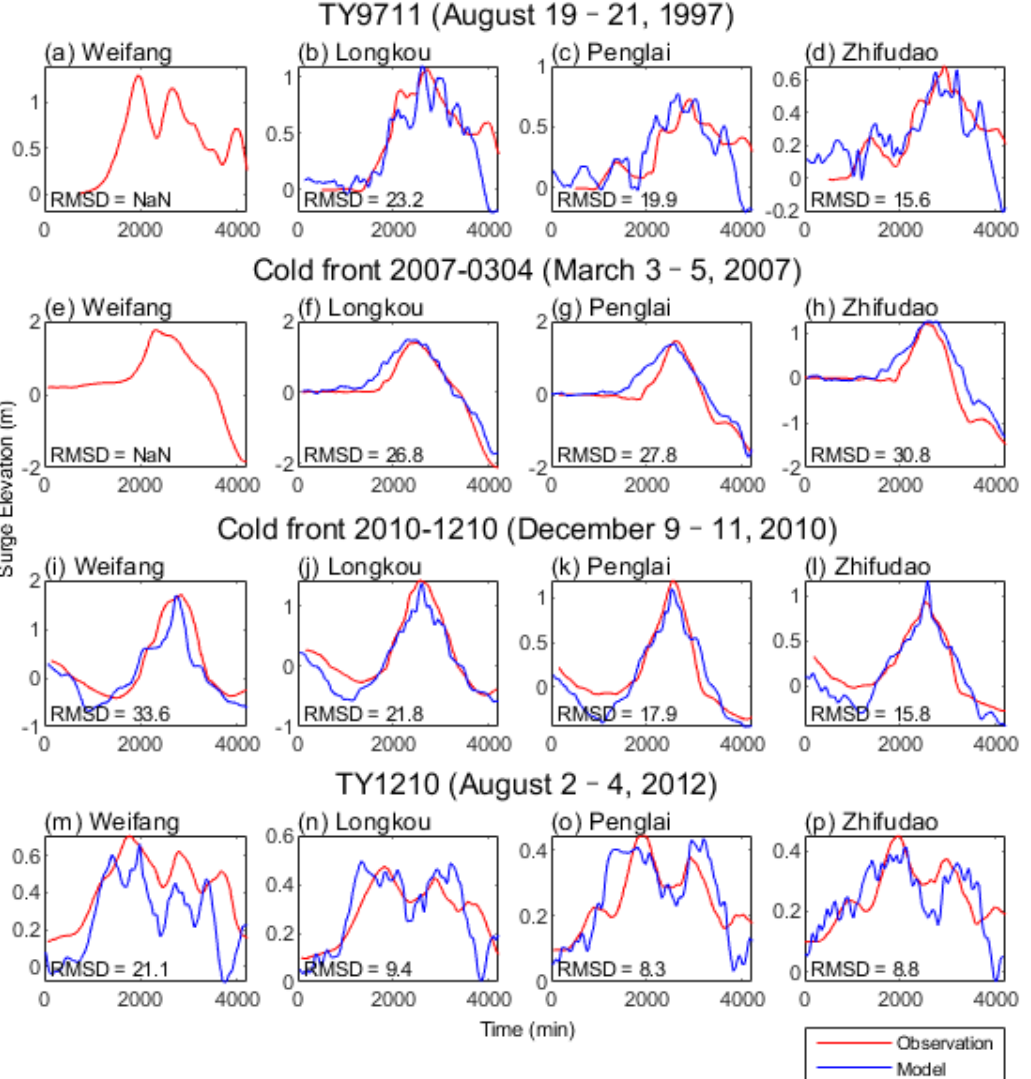
Figure 4. Detided water level from observations (blue) and model simulations (red): ( a – d ) caused by Typhoon Winnie during 19–21 August 1997, ( e – h ) caused by a strong cold front during 3–5 March 2007, ( i – l ) caused by a strong cold front during 9–11 December 2010, ( m – p ) caused by Typhoon Damrey during 2–4 August 2012. The blue lines in ( a ) and ( e ) are not plotted because no observation is available for Weifang during that